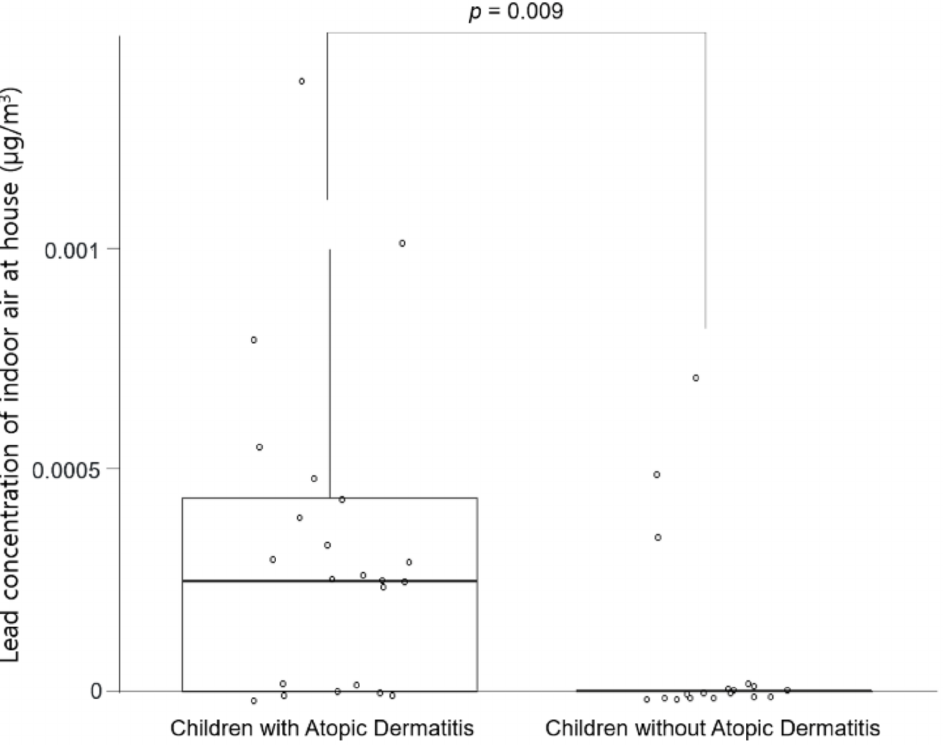
Figure 1. Differences in lead concentration in indoor air in the houses of children with and without atopic dermatitis (Mann–Whitney